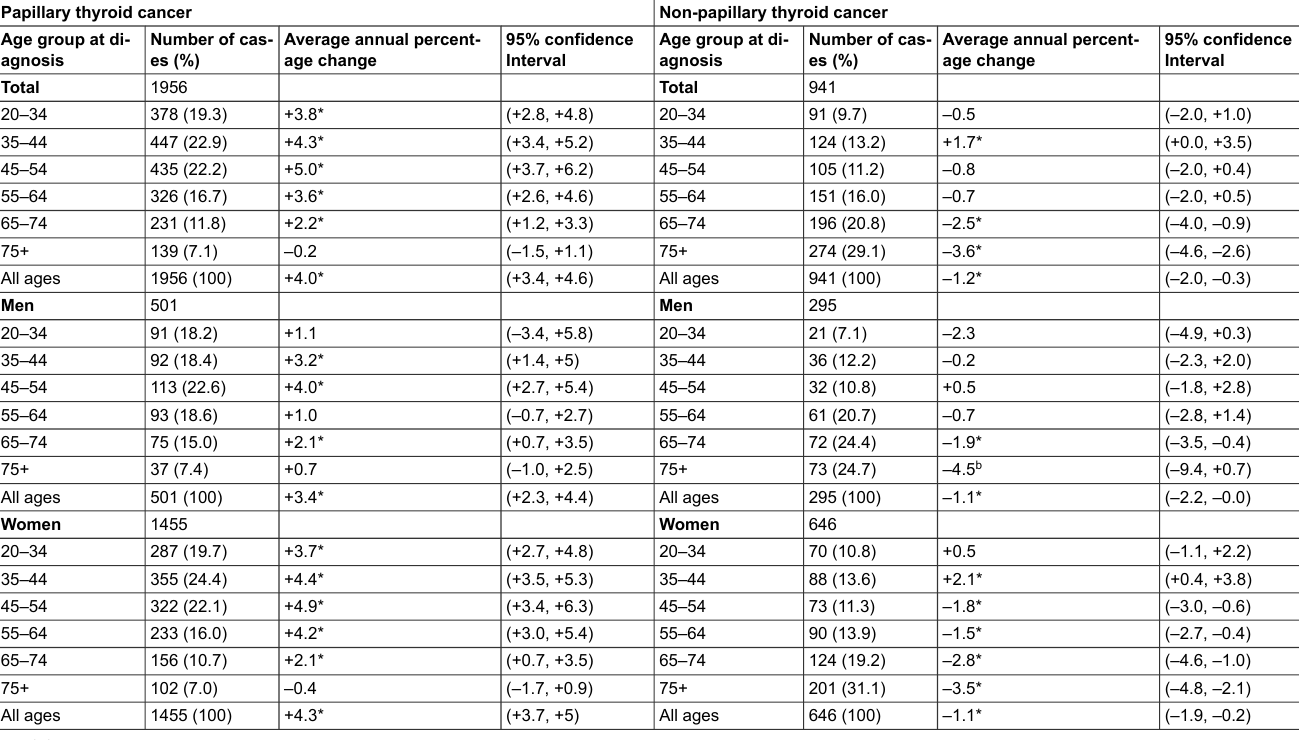
Table 2: Trends in papillary thyroid cancer and non-papillary thyroid cancer incidence by sex and age groups in the canton of Zurich 1980–2016. Papillary thyroid cancer